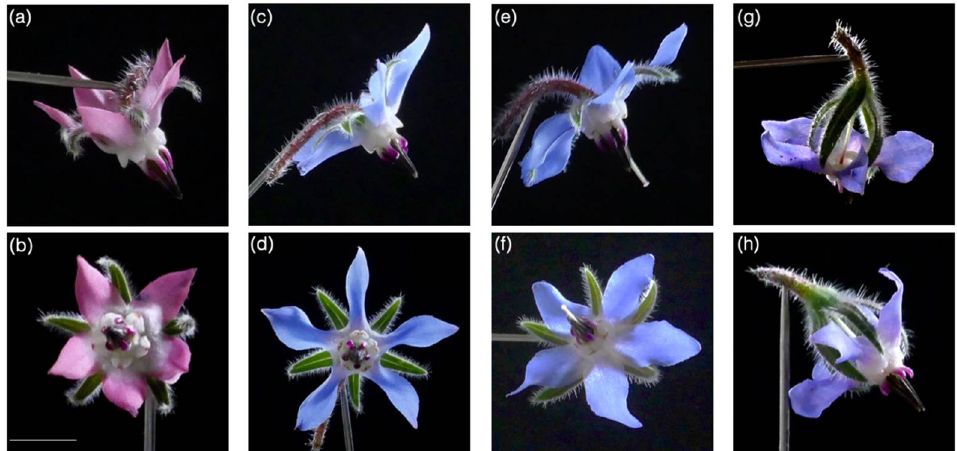
Figure 1. Flower development during anthesis. ( a , b ) Stage 1, male phase just after flower opening, with pink or purple petals. ( c , d ) Stage 2, transition to female phase with blue petals and stigma inserted. ( e , f ) Stage 3, flower with blue petals and protruded receptive stigma. ( g , h ) Stage 4, wilting flower before petal abscission. Scale bar, 10 mm.